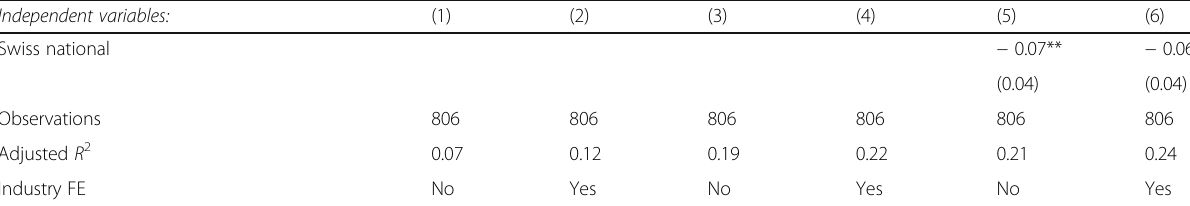
Table 4 Determinants of the use of corona loans (Continued) Independent